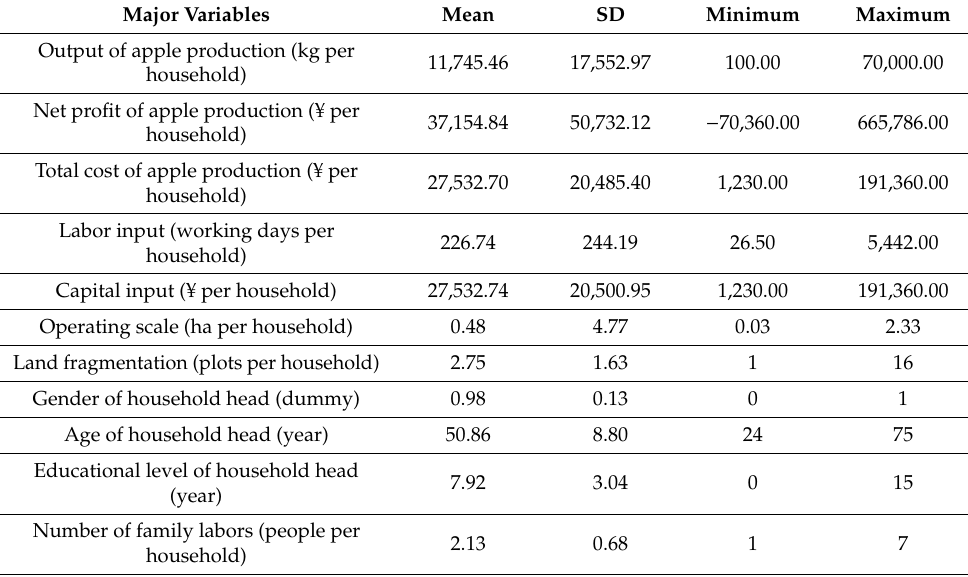
Table 1. Statistical description of the sample